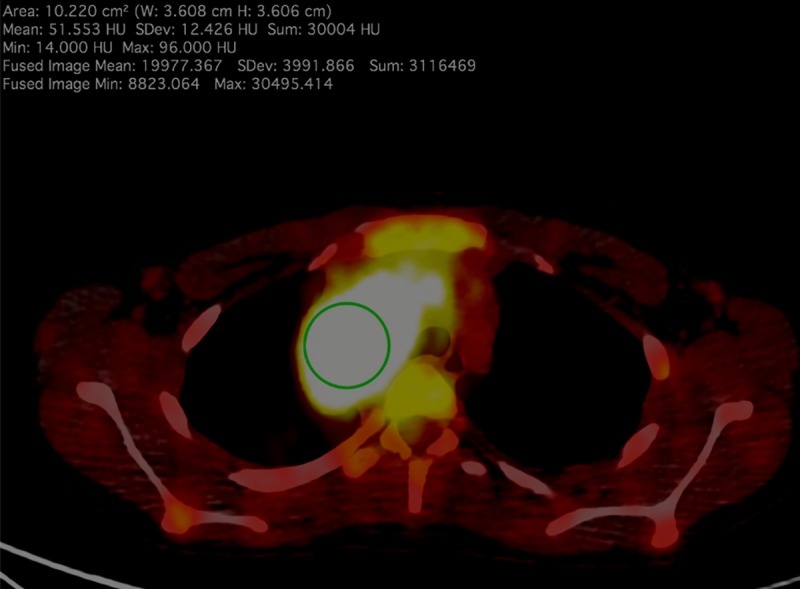
Fused PET-CT image of a female adolescent with HL; the measurement shows the highest value of both SUVmax (30.5) and XRAmax (96.0).The arithmetic mean of XRAmax was a subject to the statistical analysis.